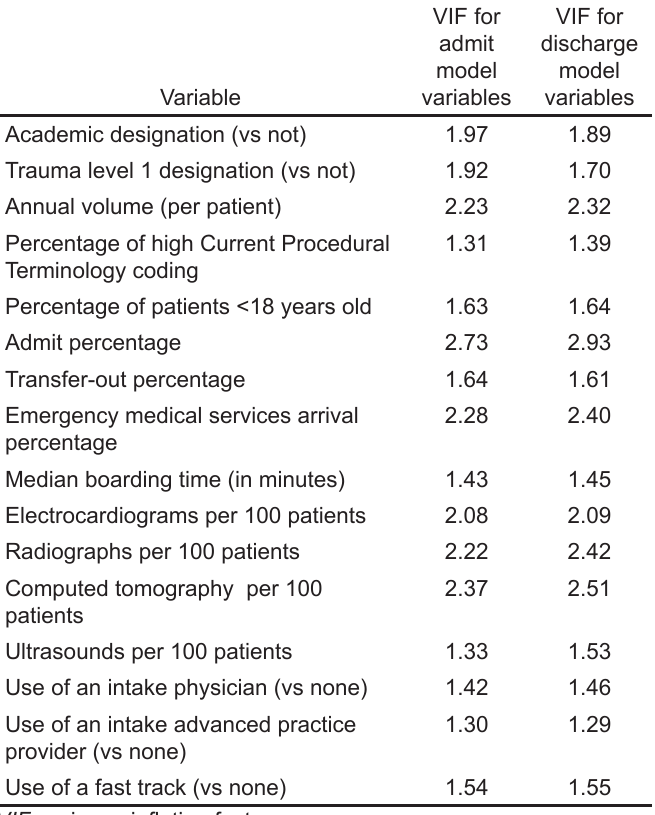
Table 1. Variance inflation factors for each variable across the admit and discharge models.